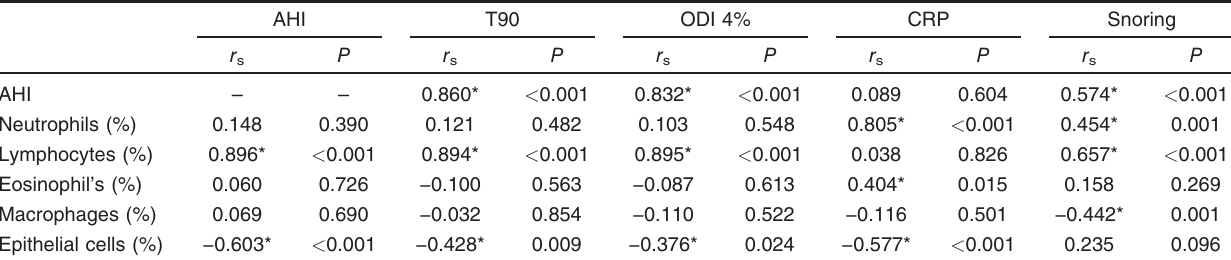
Table 2 Correlation between apnea – hypopnea index, time of sleep with oxygen saturation below 90%, oxygen desaturation index more than 4%, and C-reactive protein with different parameters in cases group